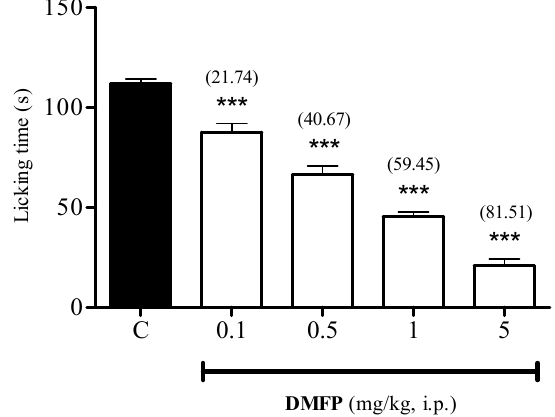
Figure 6. Effect of DMFP against glutamate-induced paw-licking test in mice. Each column represents the mean ± S.E.M. of 6 mice. The mice were pre-treated with vehicle (C), or DMFP (0.1, 0.5, 1 and 5 mg/kg, i.p.) 30 min before i.pl. injection of 20 μ L of glutamate (10 μ mol/paw). The asterisks denote the significance level *** p < 0.001, when compared with control group (one-way ANOVA followed by Dunnett’s post-hoc test). Values in parentheses are percentage of inhibition.